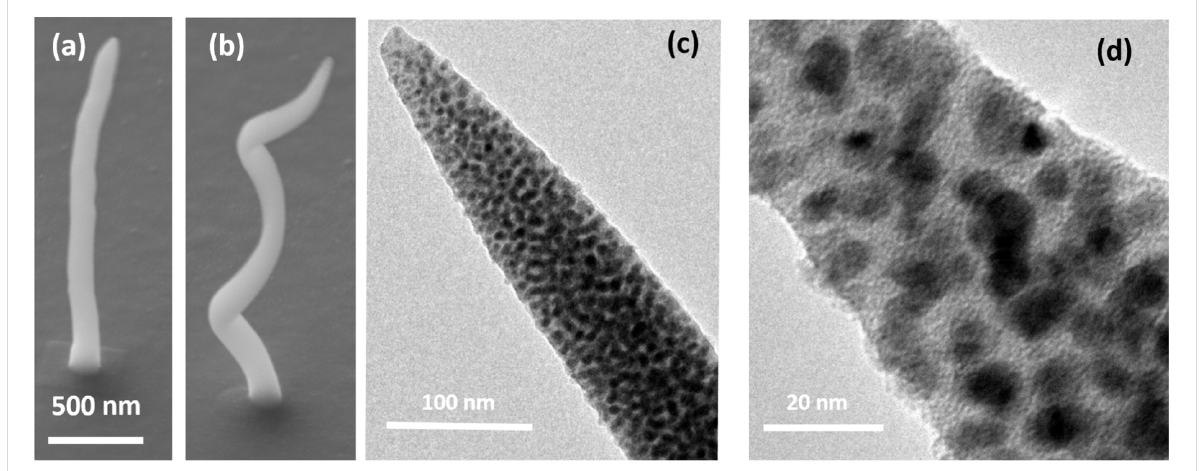
Figure 4: (a + b) Scanning electron micrographs of a single nanopillar (a) and a copper helix with three pitches (b) deposited on glass covered with 50 nm ITO, the scale of (a) and (b) is the same. (c + d) Transmission electron micrographs of a copper pillar. Visible is the typical FEBID structure of copper particles embedded in an amorphous matrix.